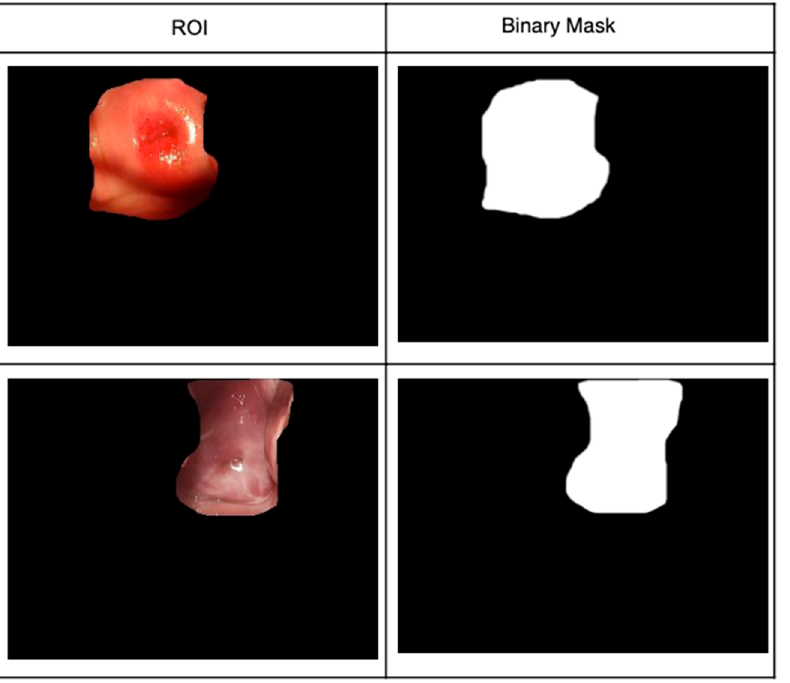
Figure 3. Manual RoI selections and their masks.